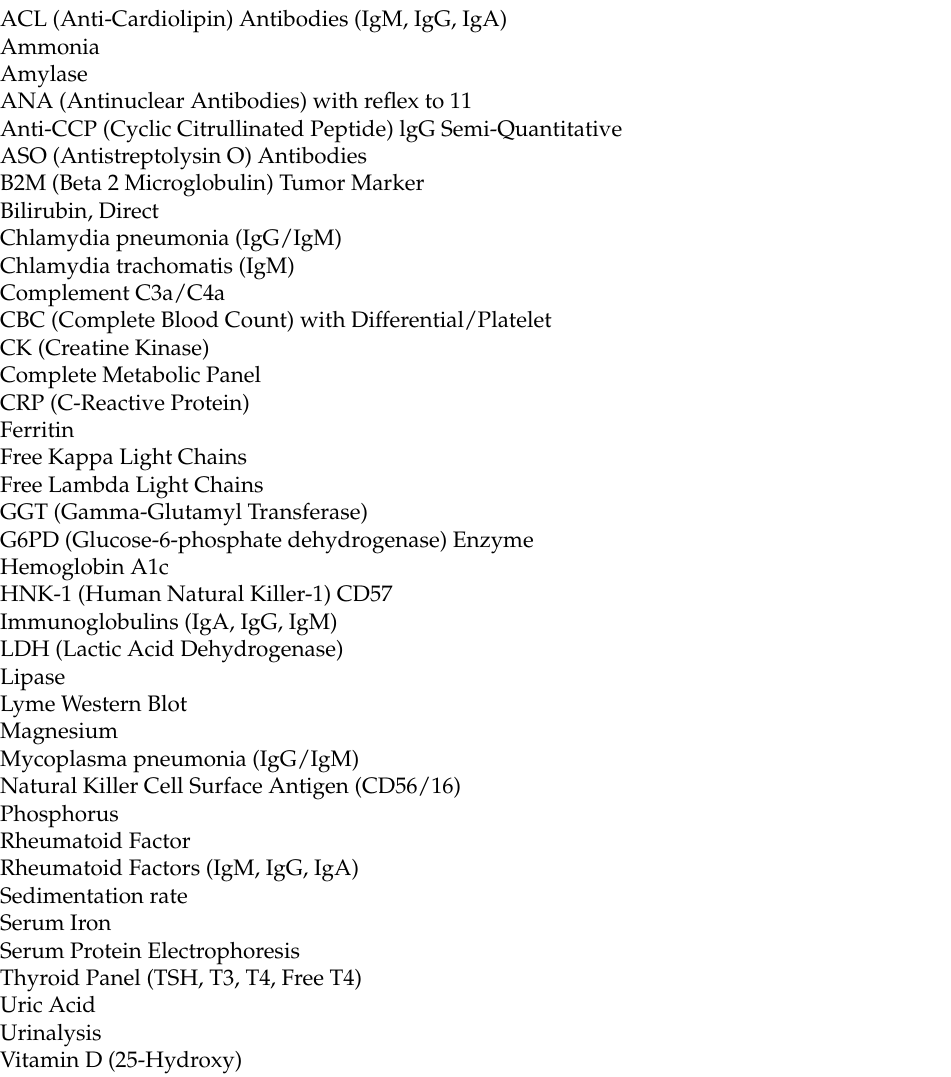
Table 2. Serology Laboratory Tests Ordered at Initial Visit to Rheumatologist (August 2013) after ME/CFS